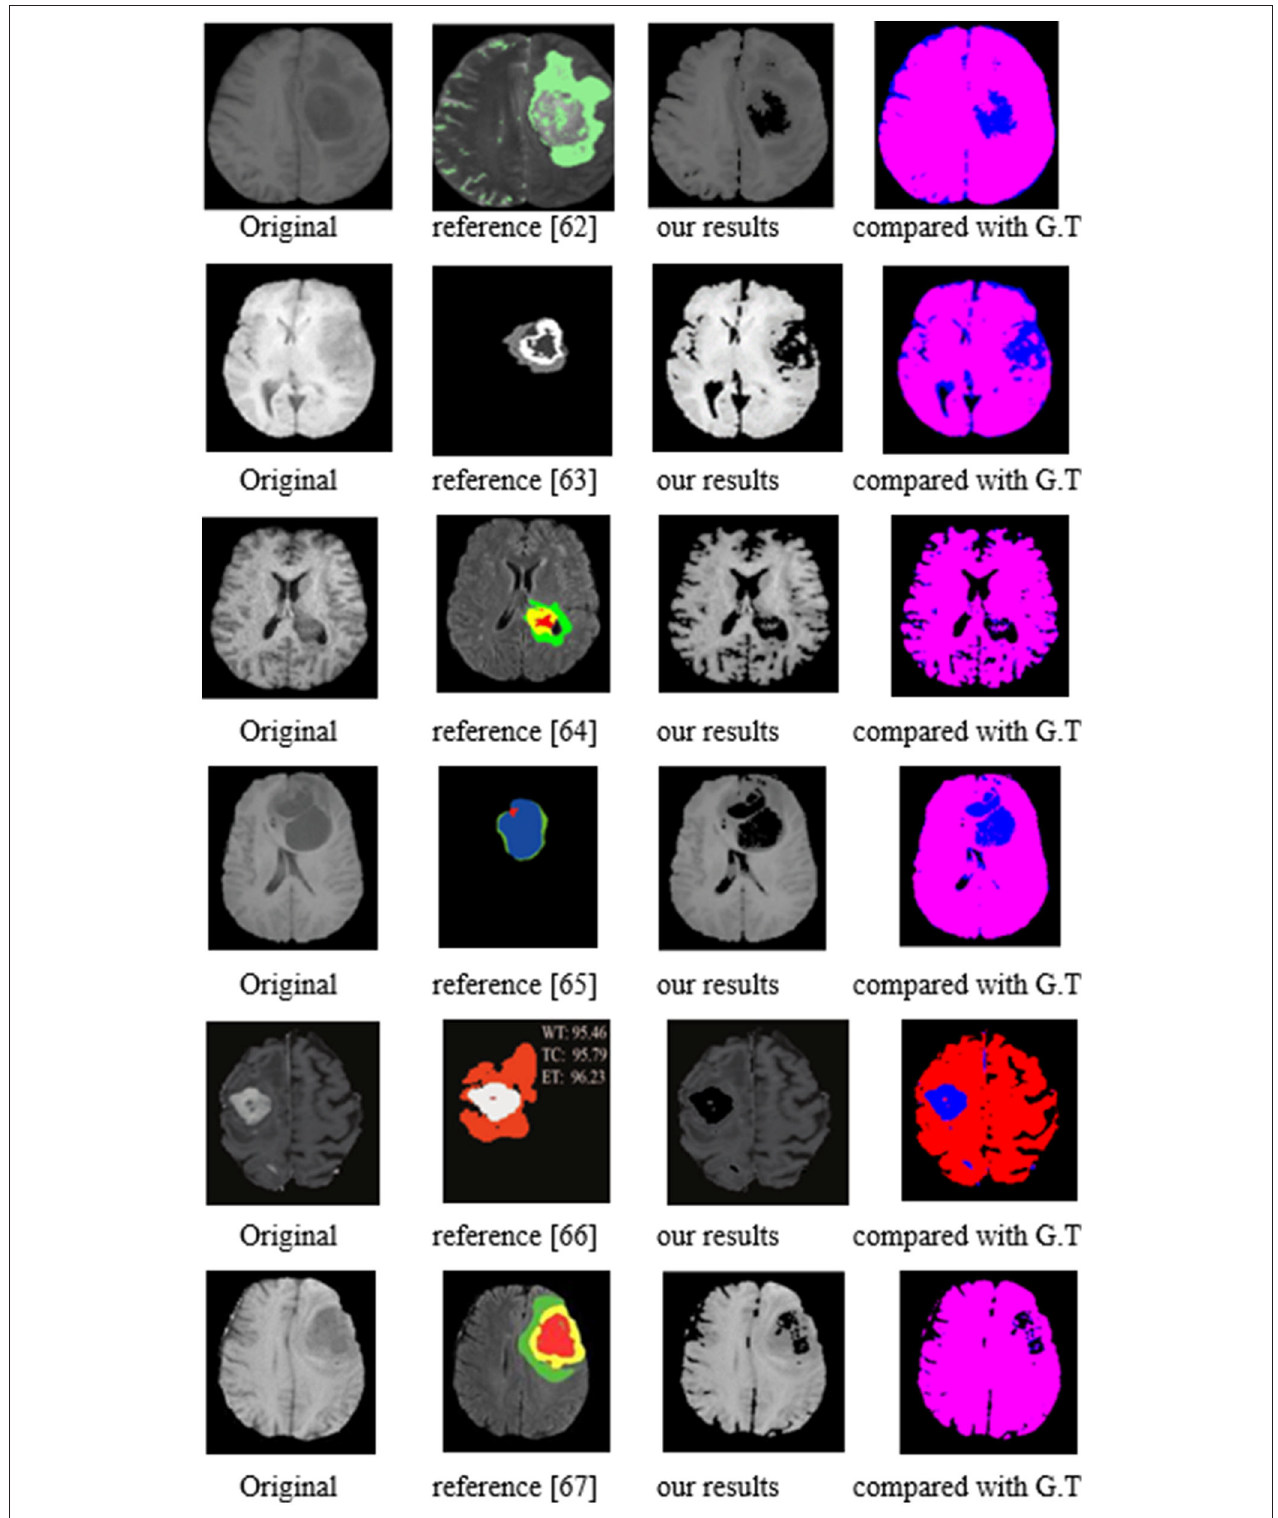
FIGURE 17 | The segmentation of the image results of Brain Tumor Segmentation (BraTS).